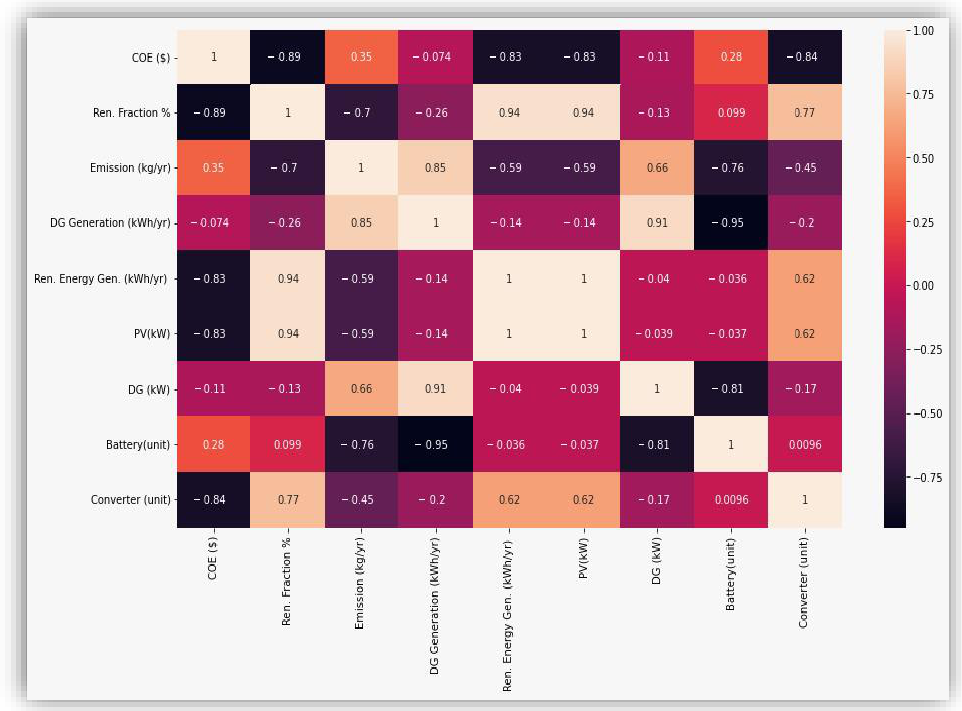
Figure 9. Heat map generated by MLR reflecting parameter values in several conditions.